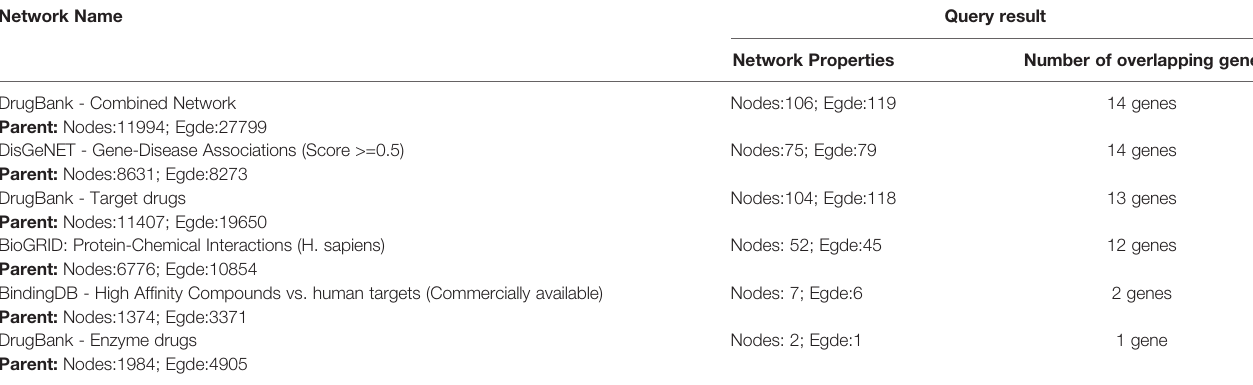
TABLE 1 | Drug-target networks were retrieved using the “ Gene Association ” module of NDEx